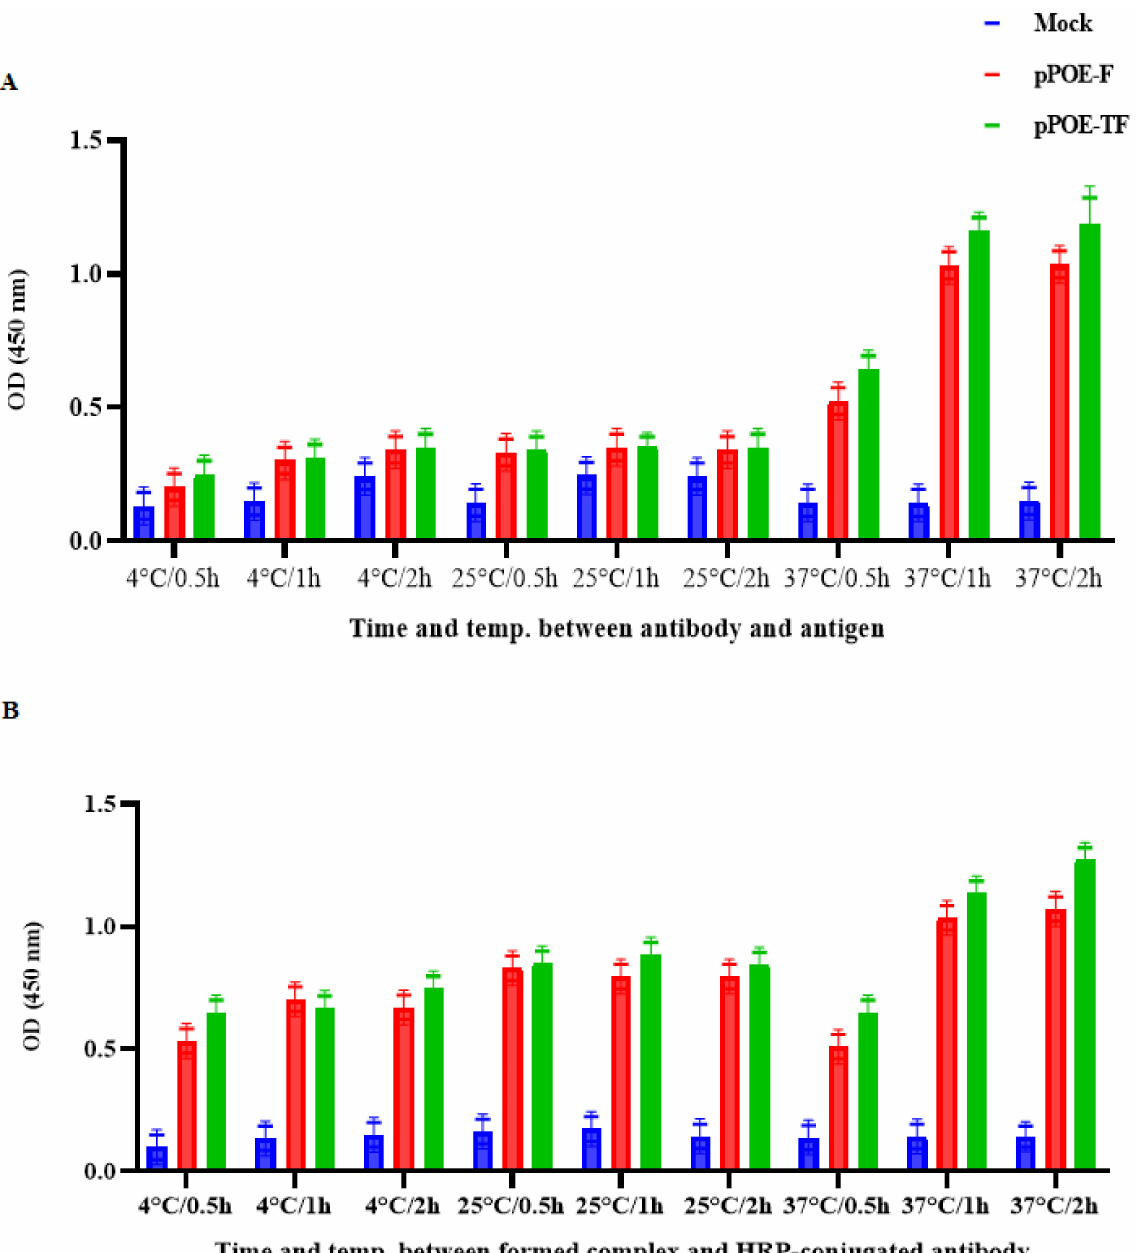
Figure 5. ( A ) Graph showing the suitable time and temperature for the reaction between antibody and antigen and ( B ) between the formed complex and enzymatic conjugate ELISA. The incubation periods and temperature were 0.5, 1, or 2 h at 4, 25, or 37 ◦ C. OD values are the mean of two independent experiments and bars represent means ± SD measured in each MPA. Differences between rats immunized with pPOE-F and pPOE-TF were statistically